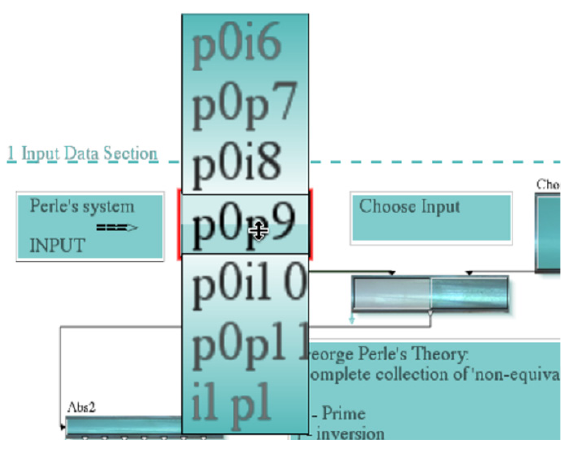
FIGURE 2 | Menu-box selection.